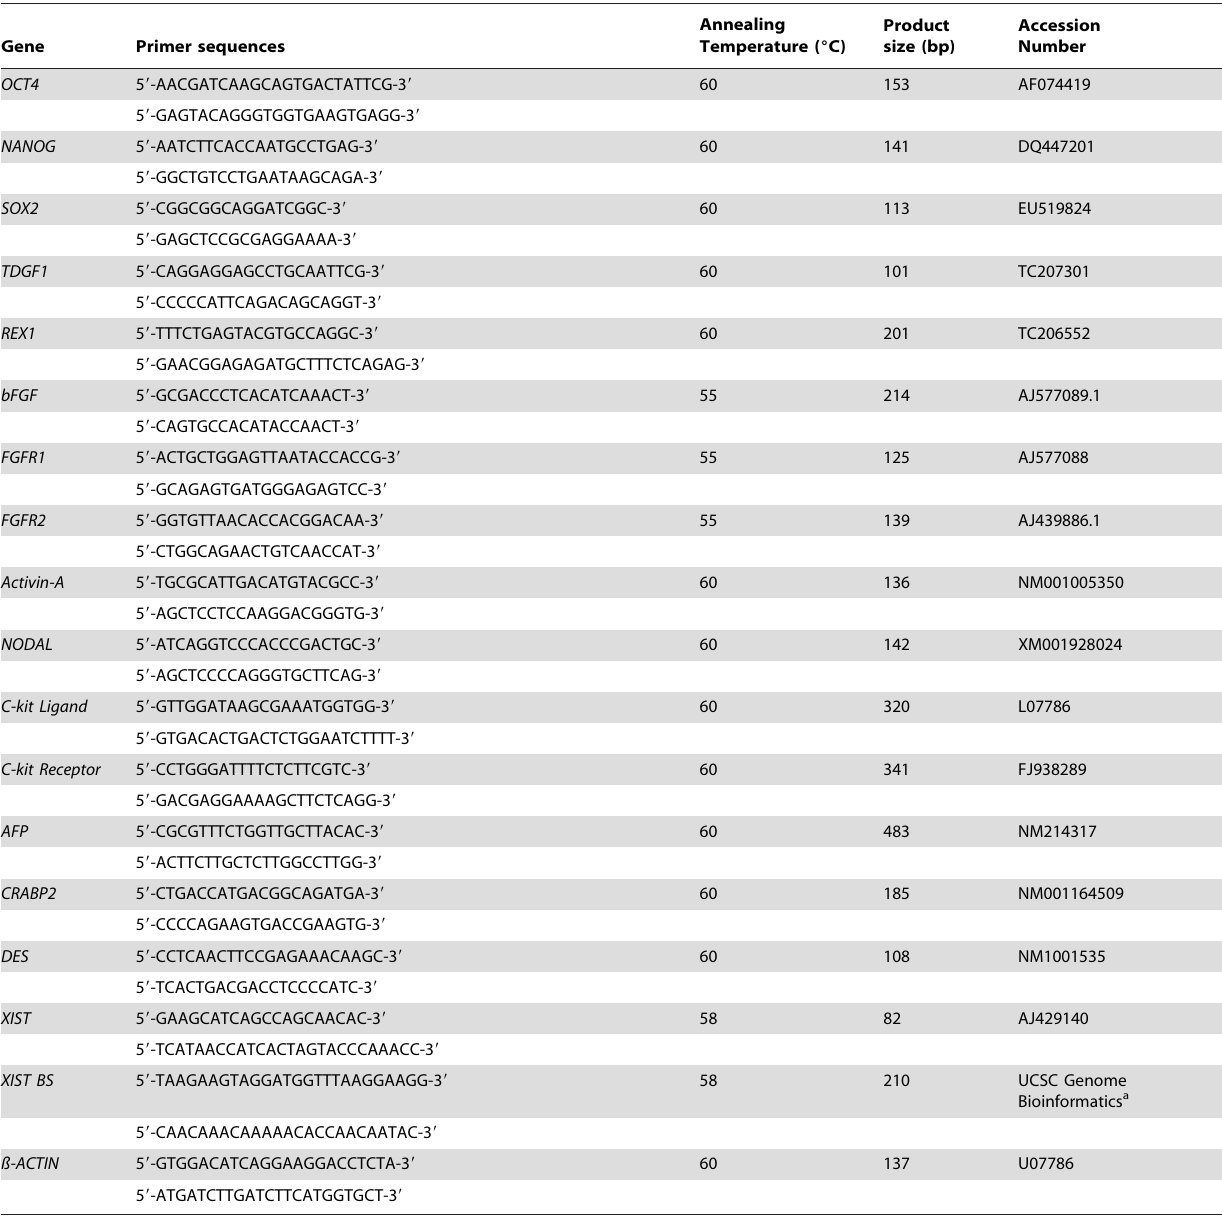
Table 1. Primers and conditions for